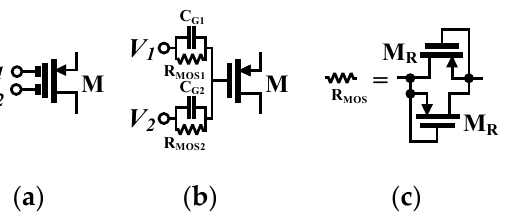
Figure 5. The multiple-input MOS transistor: ( a ) Symbol; ( b ) realization; and ( c ) realization of R MOS [34].